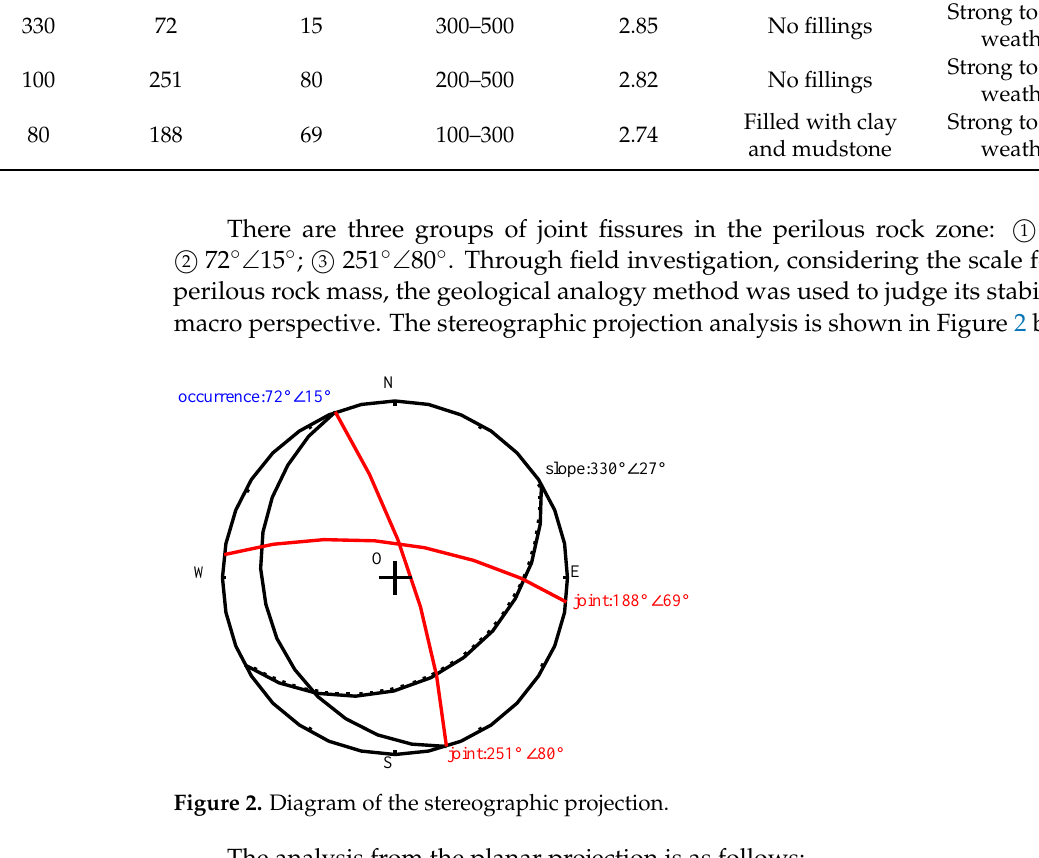
Table 2. Collapsed perilous rock belt of the coal mine industry square.